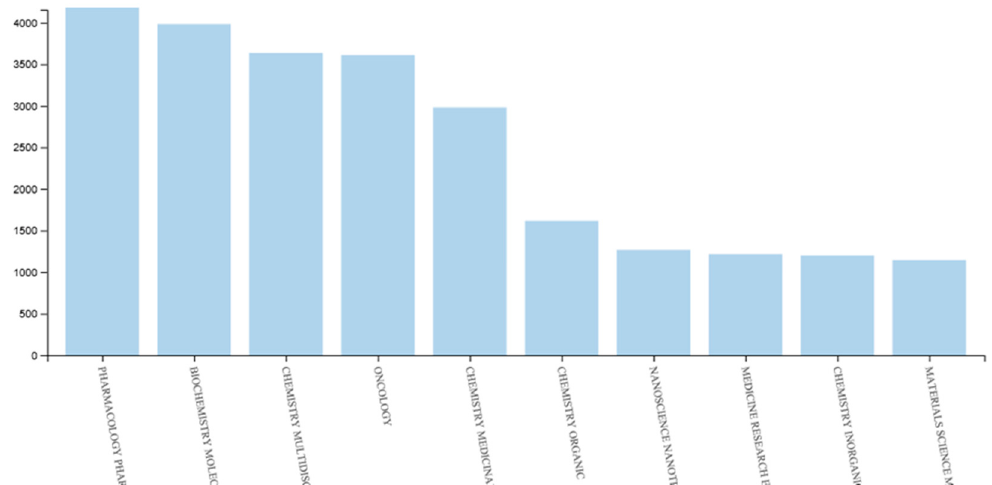
Figure 1. Results analysis for Web of Science query “anticancer” within the publication years of 2018 and 2019 [1].